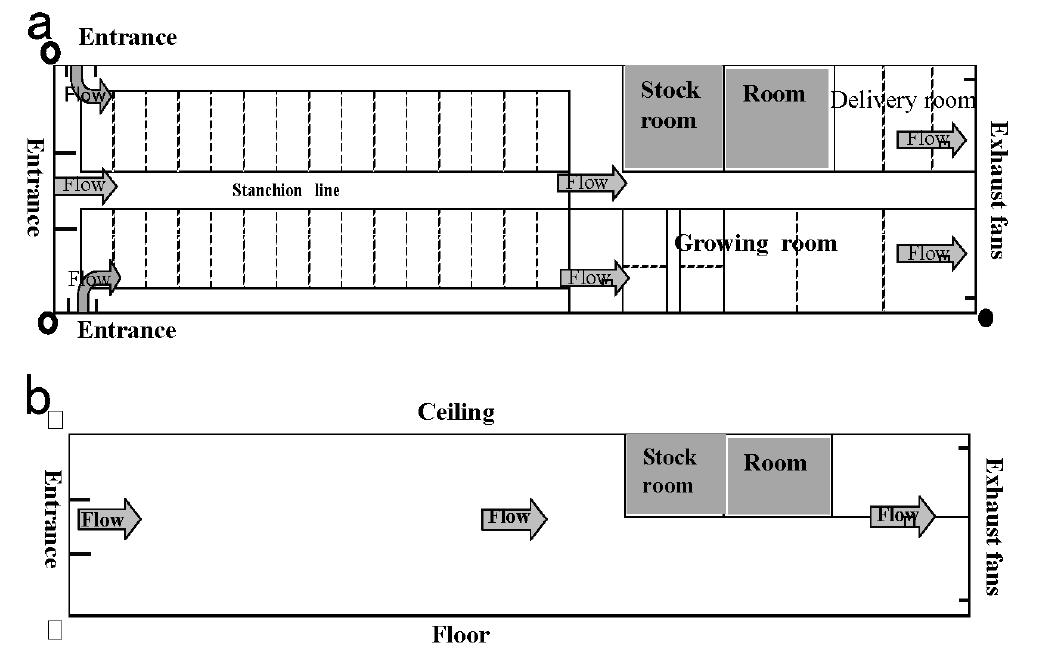
Figure 1. Tunnel ventilation system at the University Farm, Faculty of Agriculture, Utsunomiya University. (a) and (b) represent floor plans of the tunnel ventilation system (width ( ○ — ○ ) : 9 m, length ( ○ — ● ) : 43 m. The walls of the barn were made of plaster (15 mm thick ) or concrete blocks (154 mm thick), while the roof was made form corrugated galvanized irons, asbestos cement plates, and insulating materials (0.4 mm thick) (a). System viewed from above (b) Different sections of the barn (height [ □ — □] : 5 m). Arrows show images of the direction of air flow from the tunnel ventilation